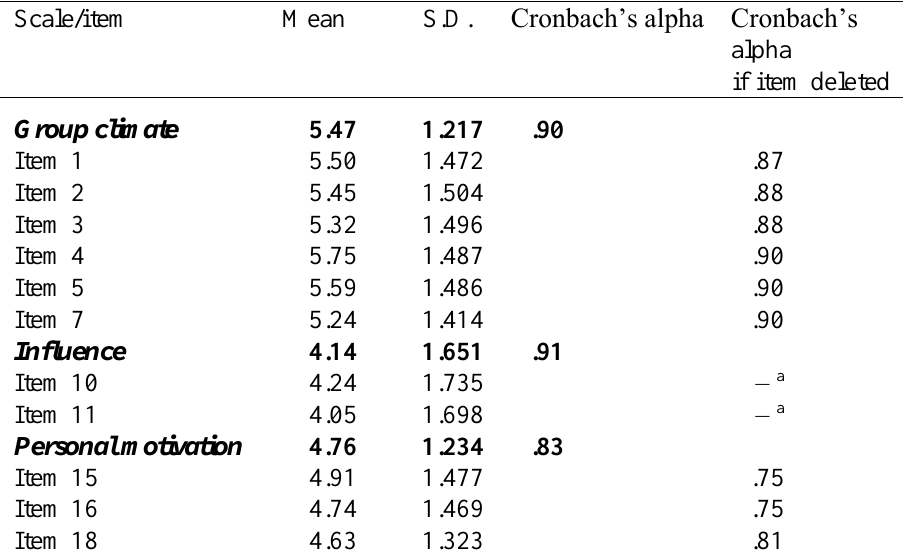
Table 5 Item and Scale Statistics, and Reliability Analysis (Cronbach’s Alpha) Total Sample (N = 467)